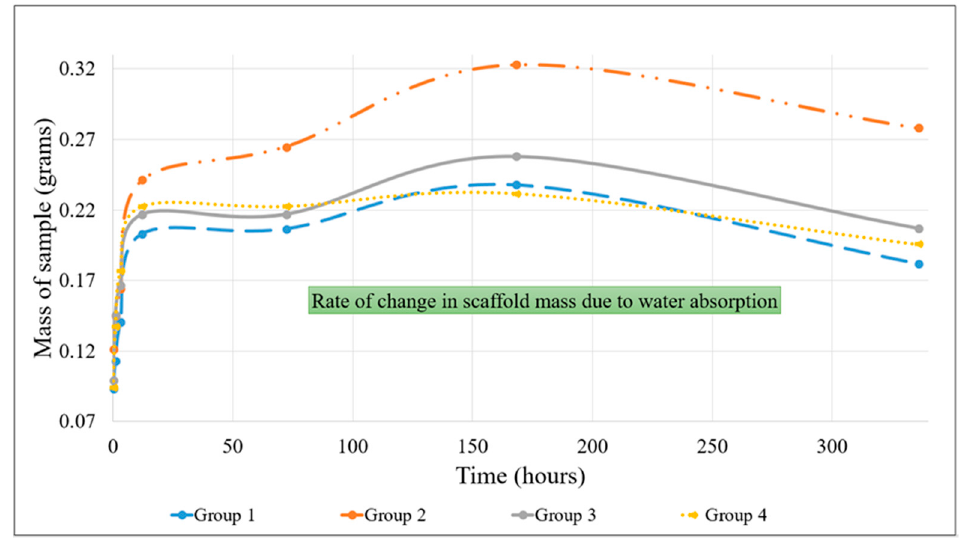
Figure 2. The rate of absorption of the samples composed of various biomaterials is indicated by the change in mass of the samples over time.